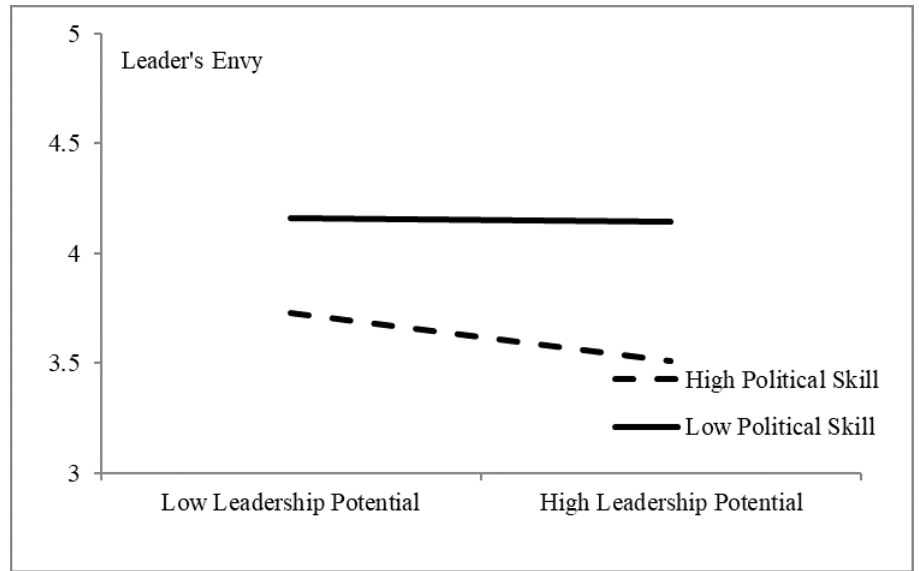
Figure 2. Moderating effects of political skill on leadership potential and leader’s envy.